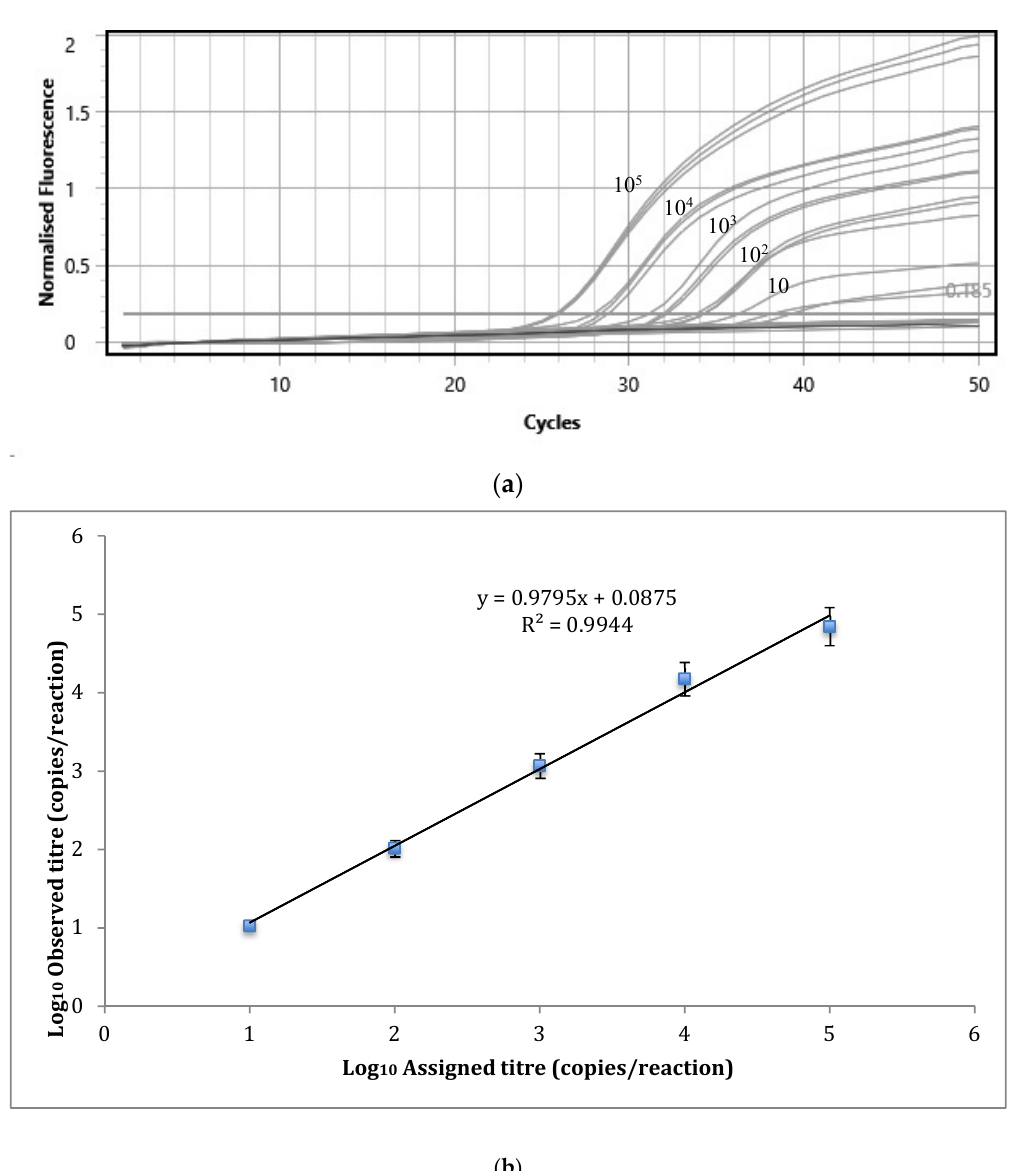
Figure 2. Sensitivity of the novel qPCR assay for L. braziliensis. ( a ) FAM channel amplification curves, using 10-fold serial dilutions from 10 5 to 0.1 copies per PCR, tested in PCR triplicate. ( b ) Graphic depiction of the linear range of detection (10 to 10 5 copies per reaction). Error bars represent 95% CI. Table 3. Summary of the Observed Precision Estimates for the novel assay.